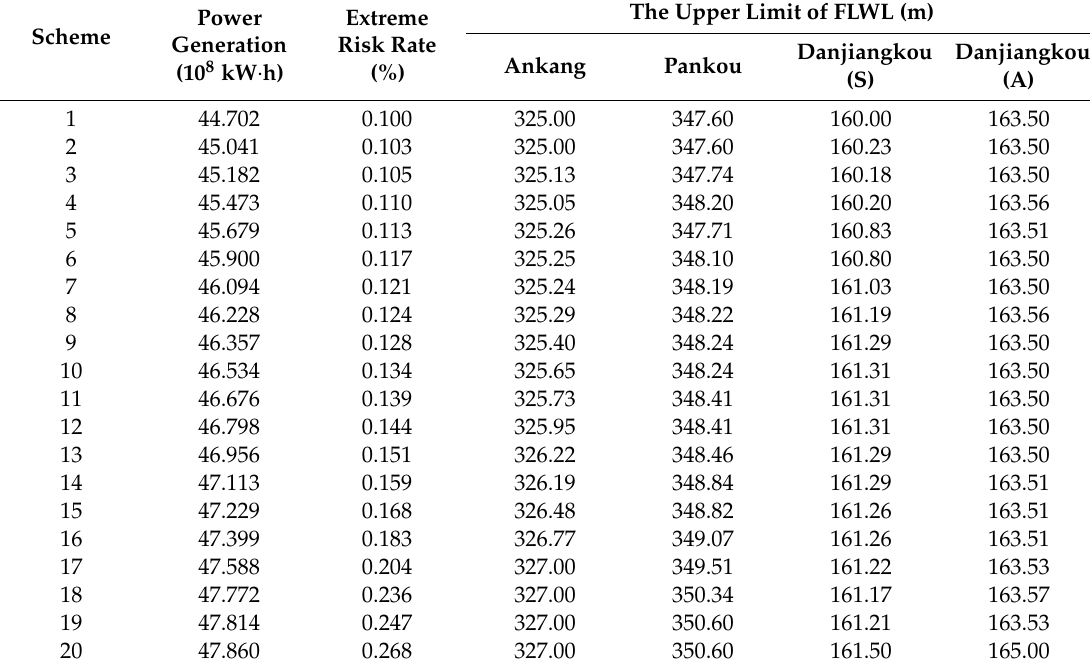
Table 3. Multi-objective optimization scheduling schemes for multi-objective optimal scheduling model of DC-FLWL for cascade